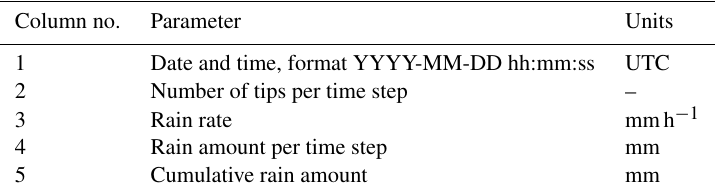
Table F1. Measured rain gauge